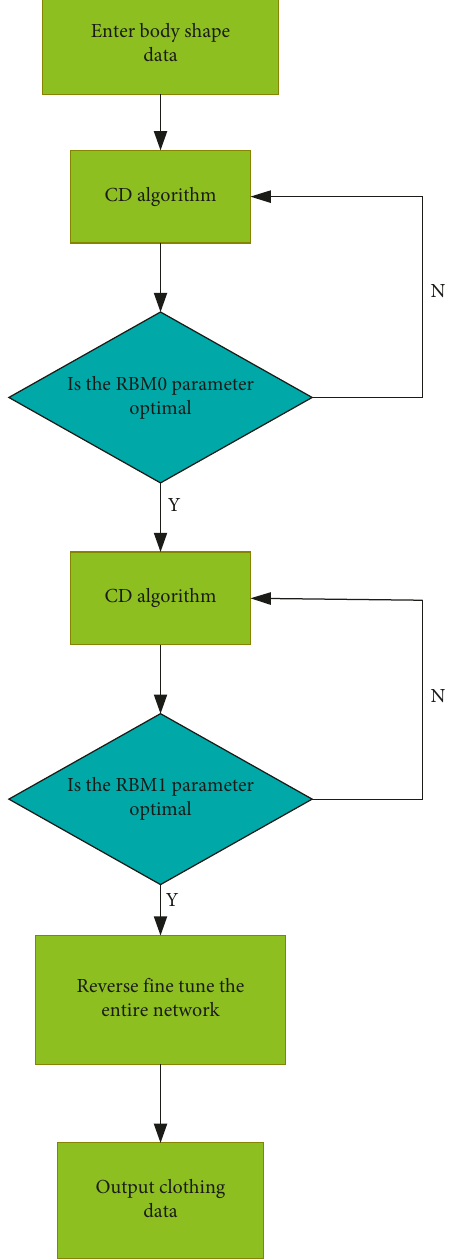
Figure 9: DBN network training